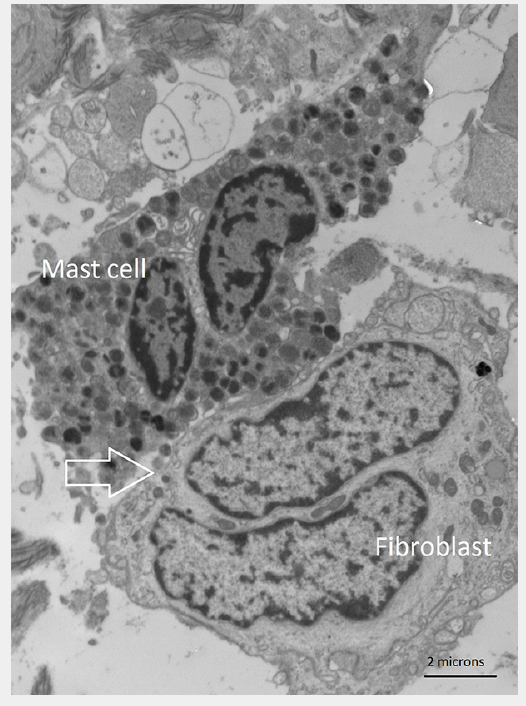
Transmission electron microscopy of the dermis in a patient with systemic sclerosis. The image shows cell-to-cell contact between a mast cell and a fibroblast with transgranulation